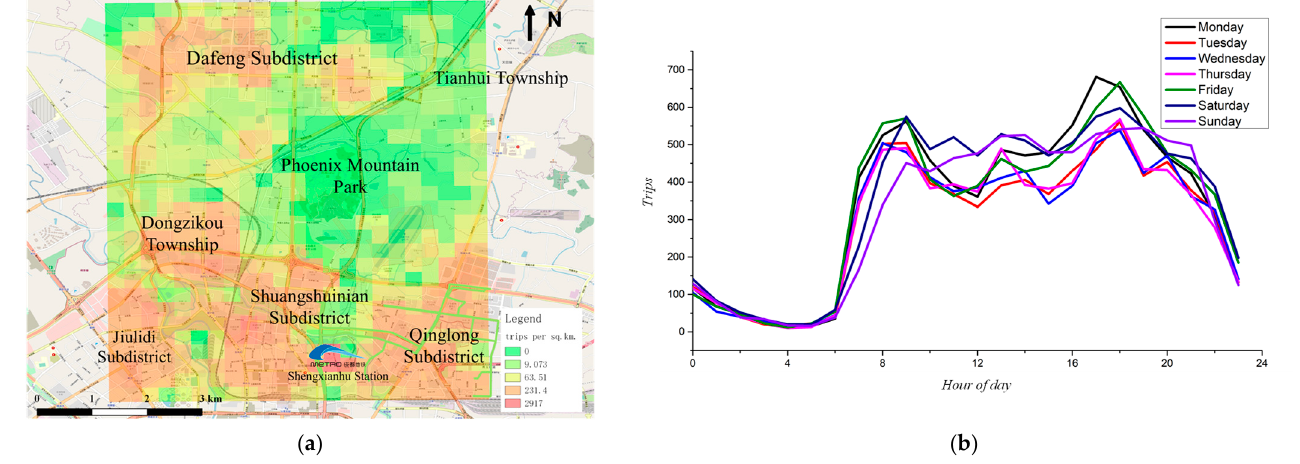
Figure 2. Spatiotemporal distribution of the dataset in the study area. ( a ) Spatial distribution of O/D points; ( b ) number of trips per hour.